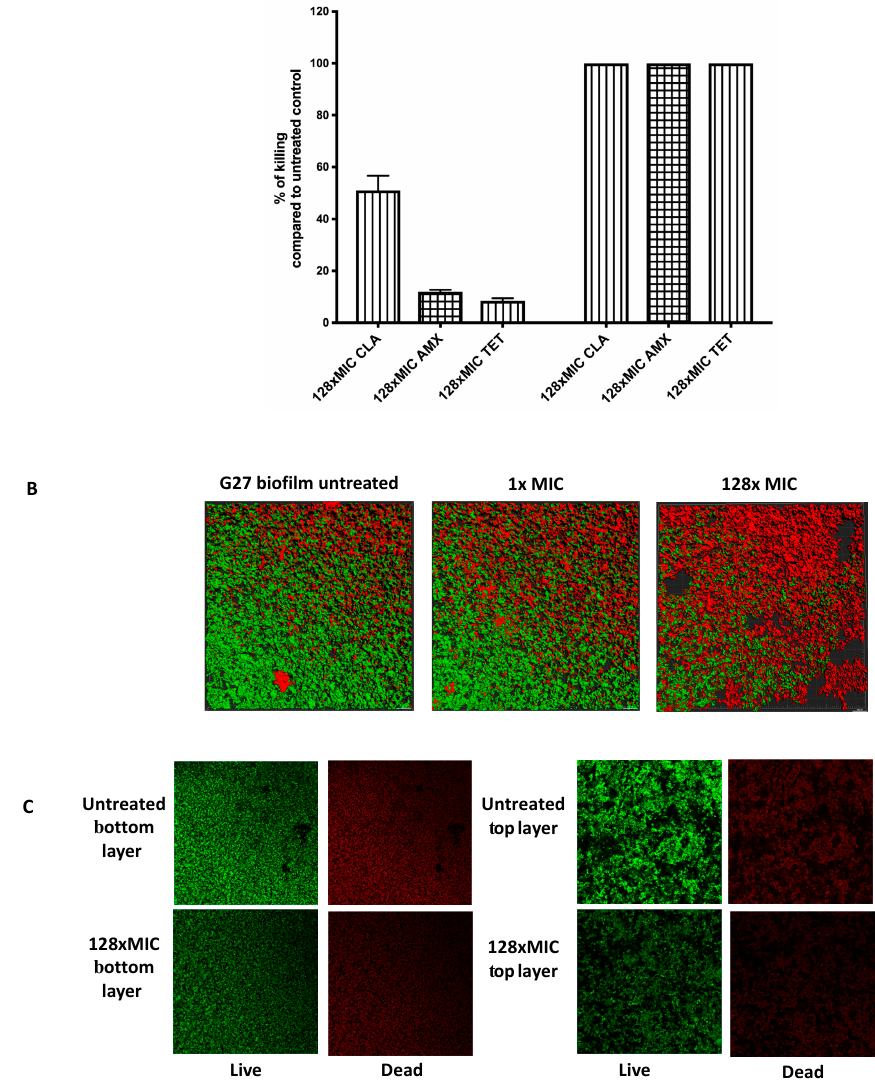
Figure 2. Viability of H. pylori biofilm and planktonic cells after antibiotic exposure. ( A ) H. pylori G27 were grown in biofilm or planktonic conditions for 48 h and then treated or not treated with either clarithromycin (CLR), amoxicillin (AMX), and tetracycline (TET) for an additional 24 h, as described in Figure 1. After treatment, samples were plated to determine colony-forming units (CFU) and compared to the untreated control, to determine the % killing. ( B ) Live and dead biomasses in H. pylori G27 biofilm treated or not treated with clarithromycin. Biofilms were visualized by confocal laser scanning microscopy (CLSM) with LIVE / DEAD viability strain. Viable cells exhibit green fluorescence, whereas dead and damaged cells exhibit red fluorescence. These images are three-dimensional (3D) reconstructions from an average of 19 image stacks assembled using Imaris software. ( C ) Images were taken from the bottom and top layers of H. pylori G27 biofilm treated or not treated with 128 × MIC of clarithromycin.